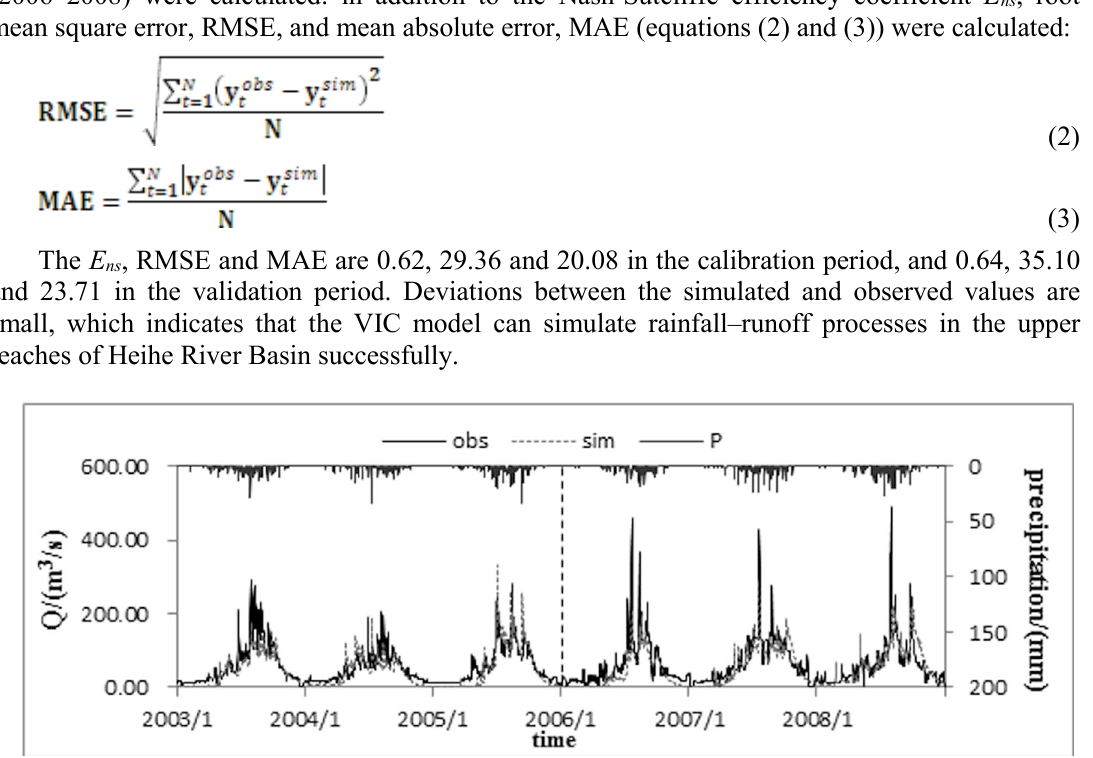
Fig. 2 Simulation results of the VIC